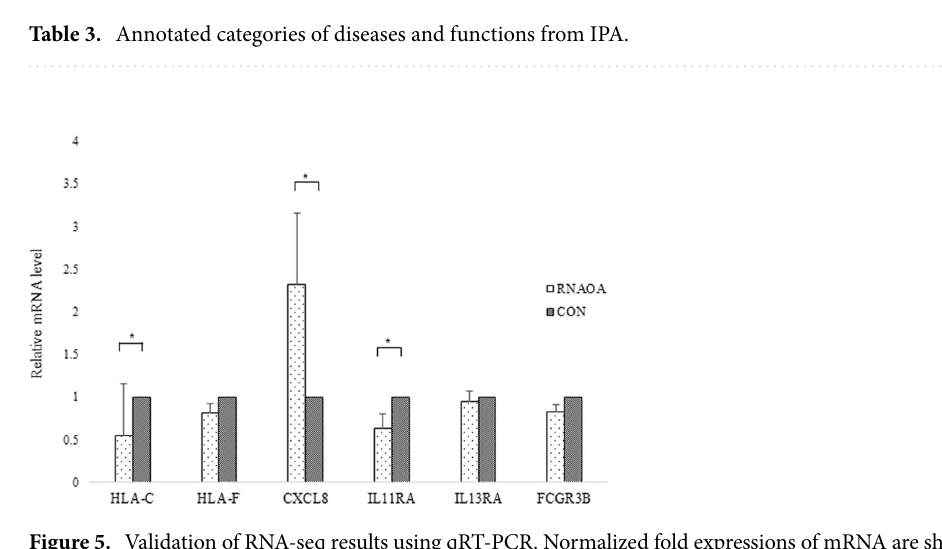
Figure 5. Validation of RNA-seq results using qRT-PCR. Normalized fold expressions of mRNA are shown. Error bar represents mean ± standard error. Mann–Whitney U tests were used to compare gene expression levels (* P <